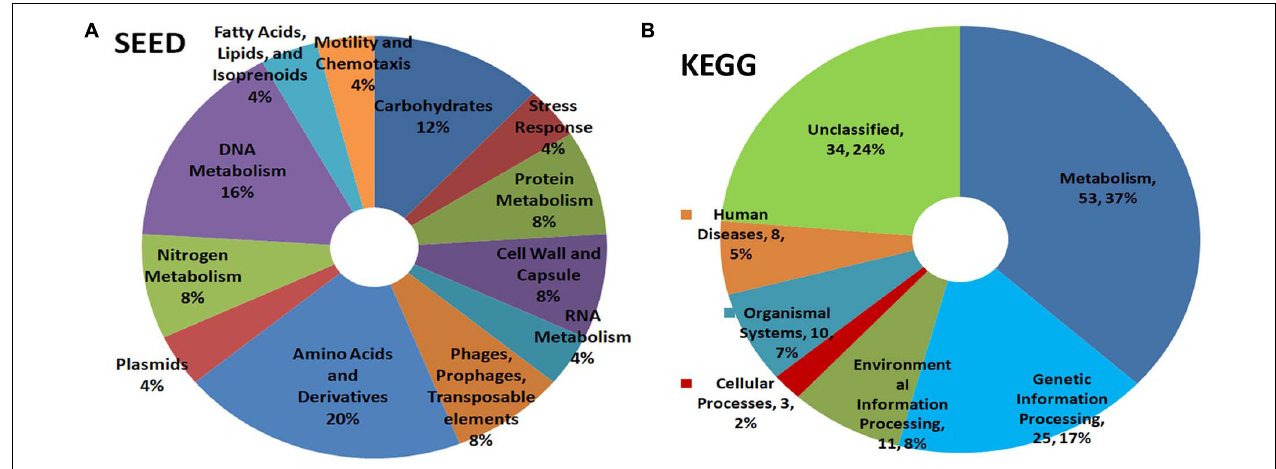
FIGURE 6 | Illumina HiSeq NGS based whole genome metagenomics on watermelon seed-embryo bacterial microbiome functional profiling as per (A) SEED and (B) KEGG